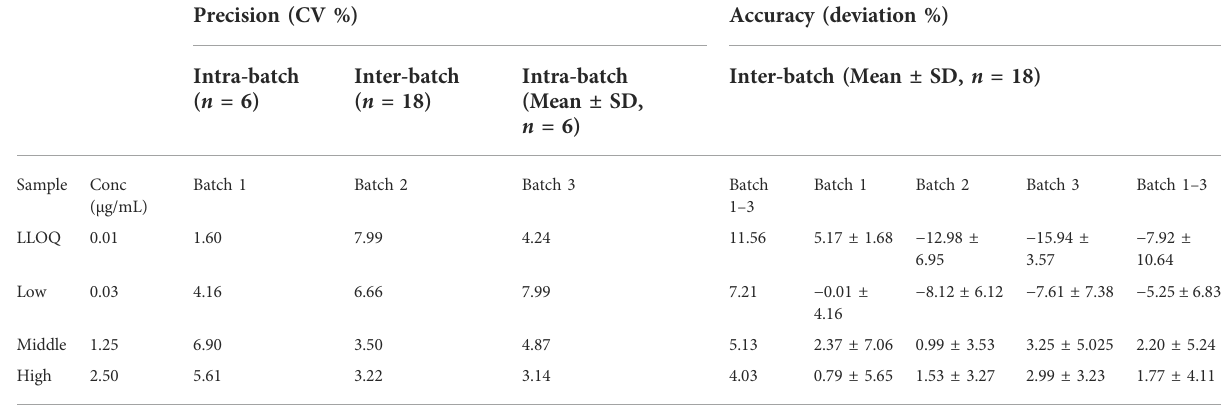
TABLE 1 Validation results of precision and accuracy. The coef fi cient of variation was within 20% for the LLOQ and within 15% for the higher concentrations samples in each batch. The deviation from the spiked concentration was within 20% for the LLOQ and within 15% for the higher concentrations. The LLOQ was 0.01 μ g/mL.